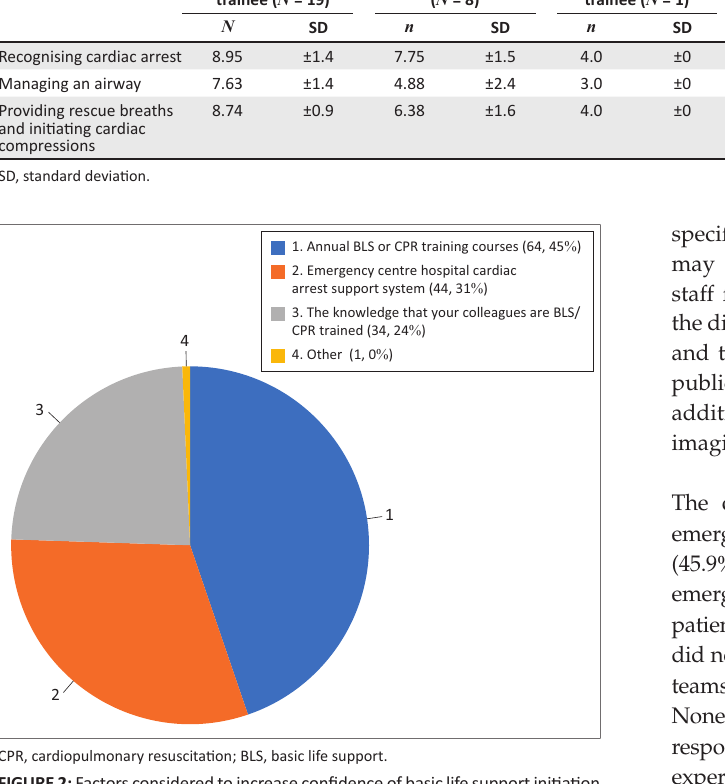
TABLE 2: Mean (and standard deviation) self-reported confidence levels of participants out of a score of 10 (where 10 was very confident and 0 was no confidence). Confidence variable Radiology trainee ( N = 19)